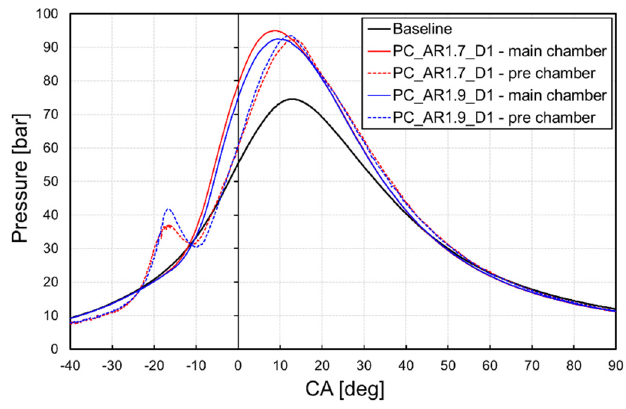
Figure 11. Simulated pressure traces during combustion (dashed line: pre-chamber pressure, solid line: main combustion chamber pressure): comparison between standard engine and engine equipped with two pre-chambers with different aspect ratio.